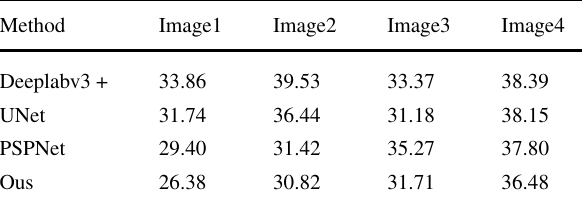
Table 3 RMSE values for different methods